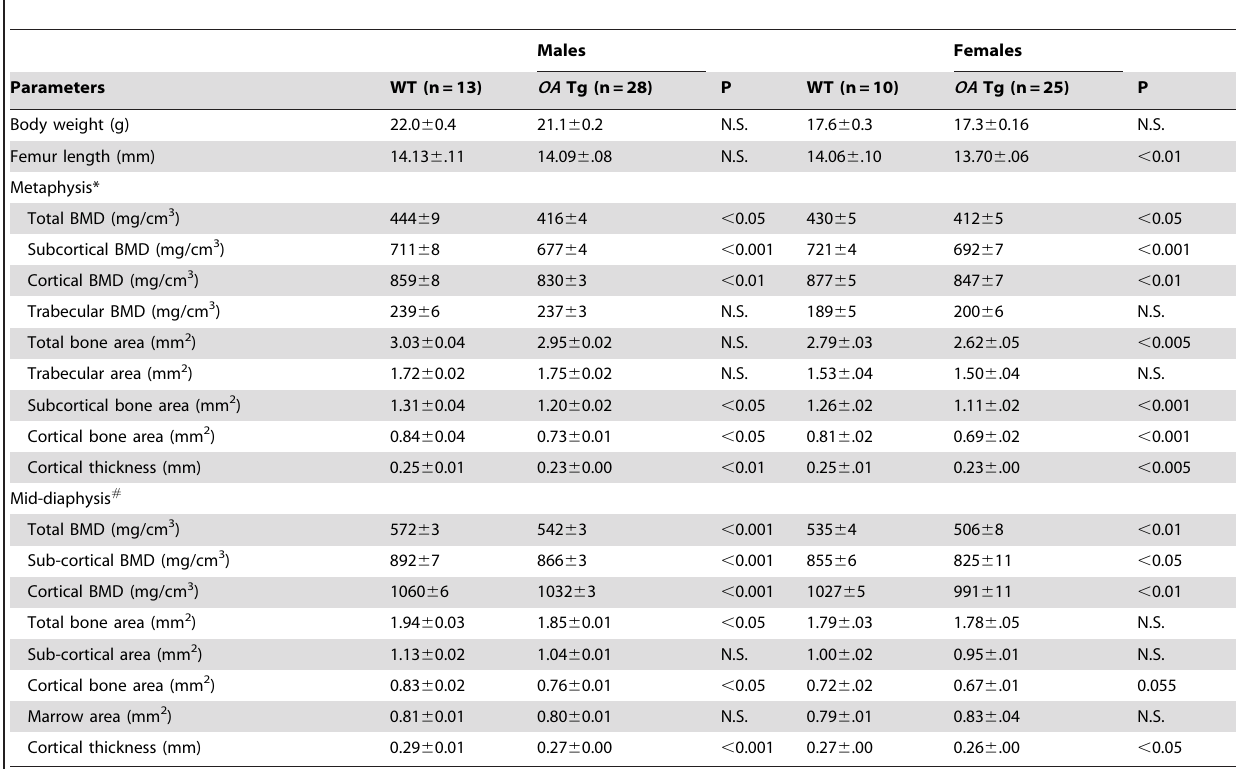
Table 1. Comparison of bone and pQCT parameters of 8 weeks old OA transgenic (Tg) mice with targeted OA overexpression in osteoclastic cells to those of 8 weeks old sex-matched WT littermates (mean 6 SEM).